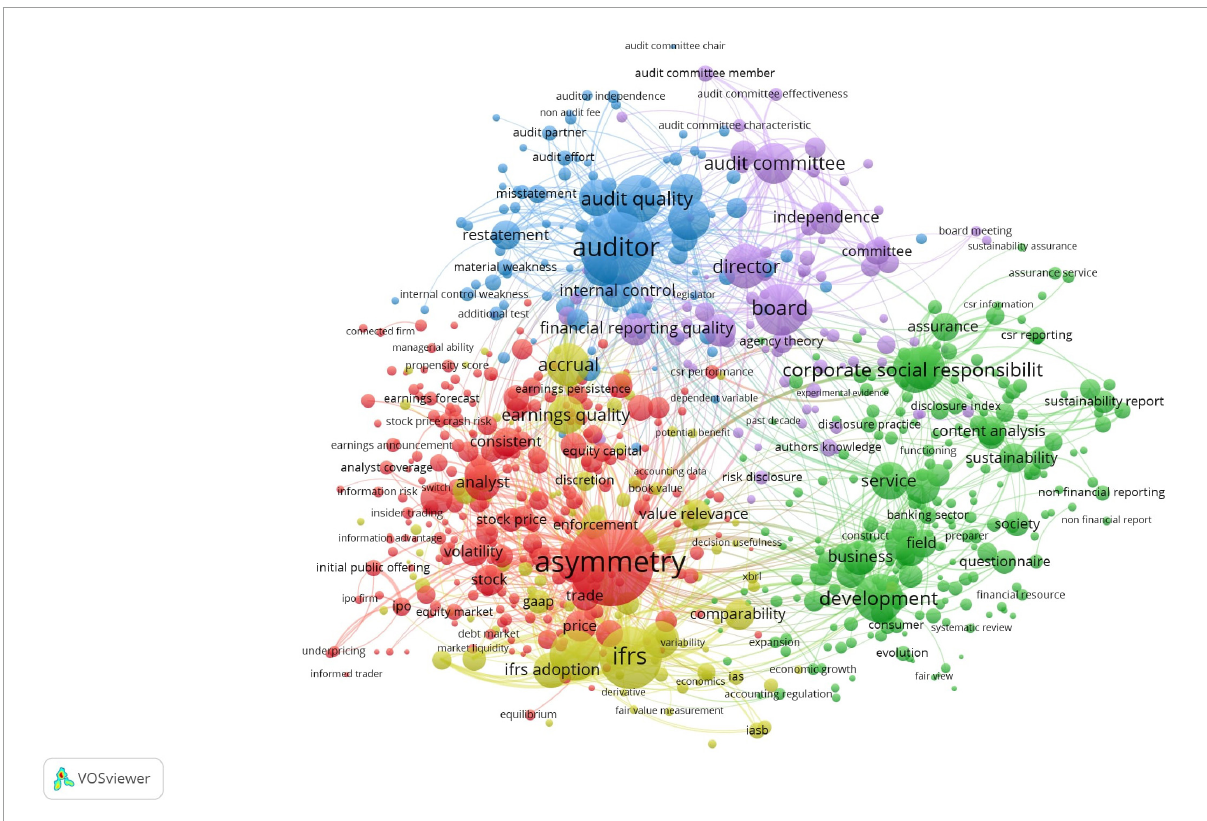
FIGURE1 Bibliometric keyword analysis, based on